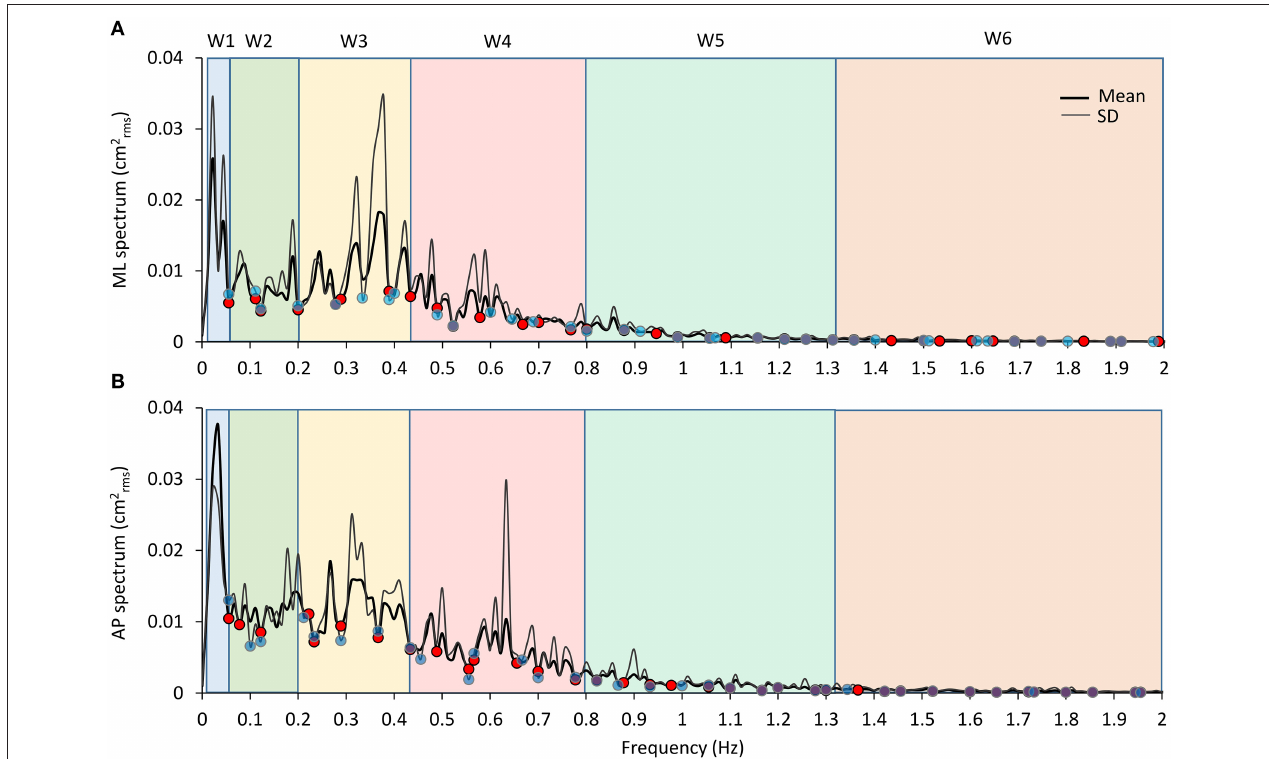
FIGURE 4 | Frequency windows identification. The graphs show the mean profile of the power spectrum (average of the profiles obtained in all the subjects, the thick black line) in the ML and AP directions [ (A,B) , respectively]. The thin dark grey lines are the corresponding profiles of the SD of the means. A similar pattern for the ML and AP spectra is obvious. The superimposed SD traces largely reproduce the up and downs of the mean spectra and show minimum values close to the relative minimum values of the mean spectra. The blue and red dots correspond to the local minima of the mean and SD traces, respectively, computed in the consecutive 0.05Hz windows. The pale-coloured rectangles indicate the frequency windows used in the